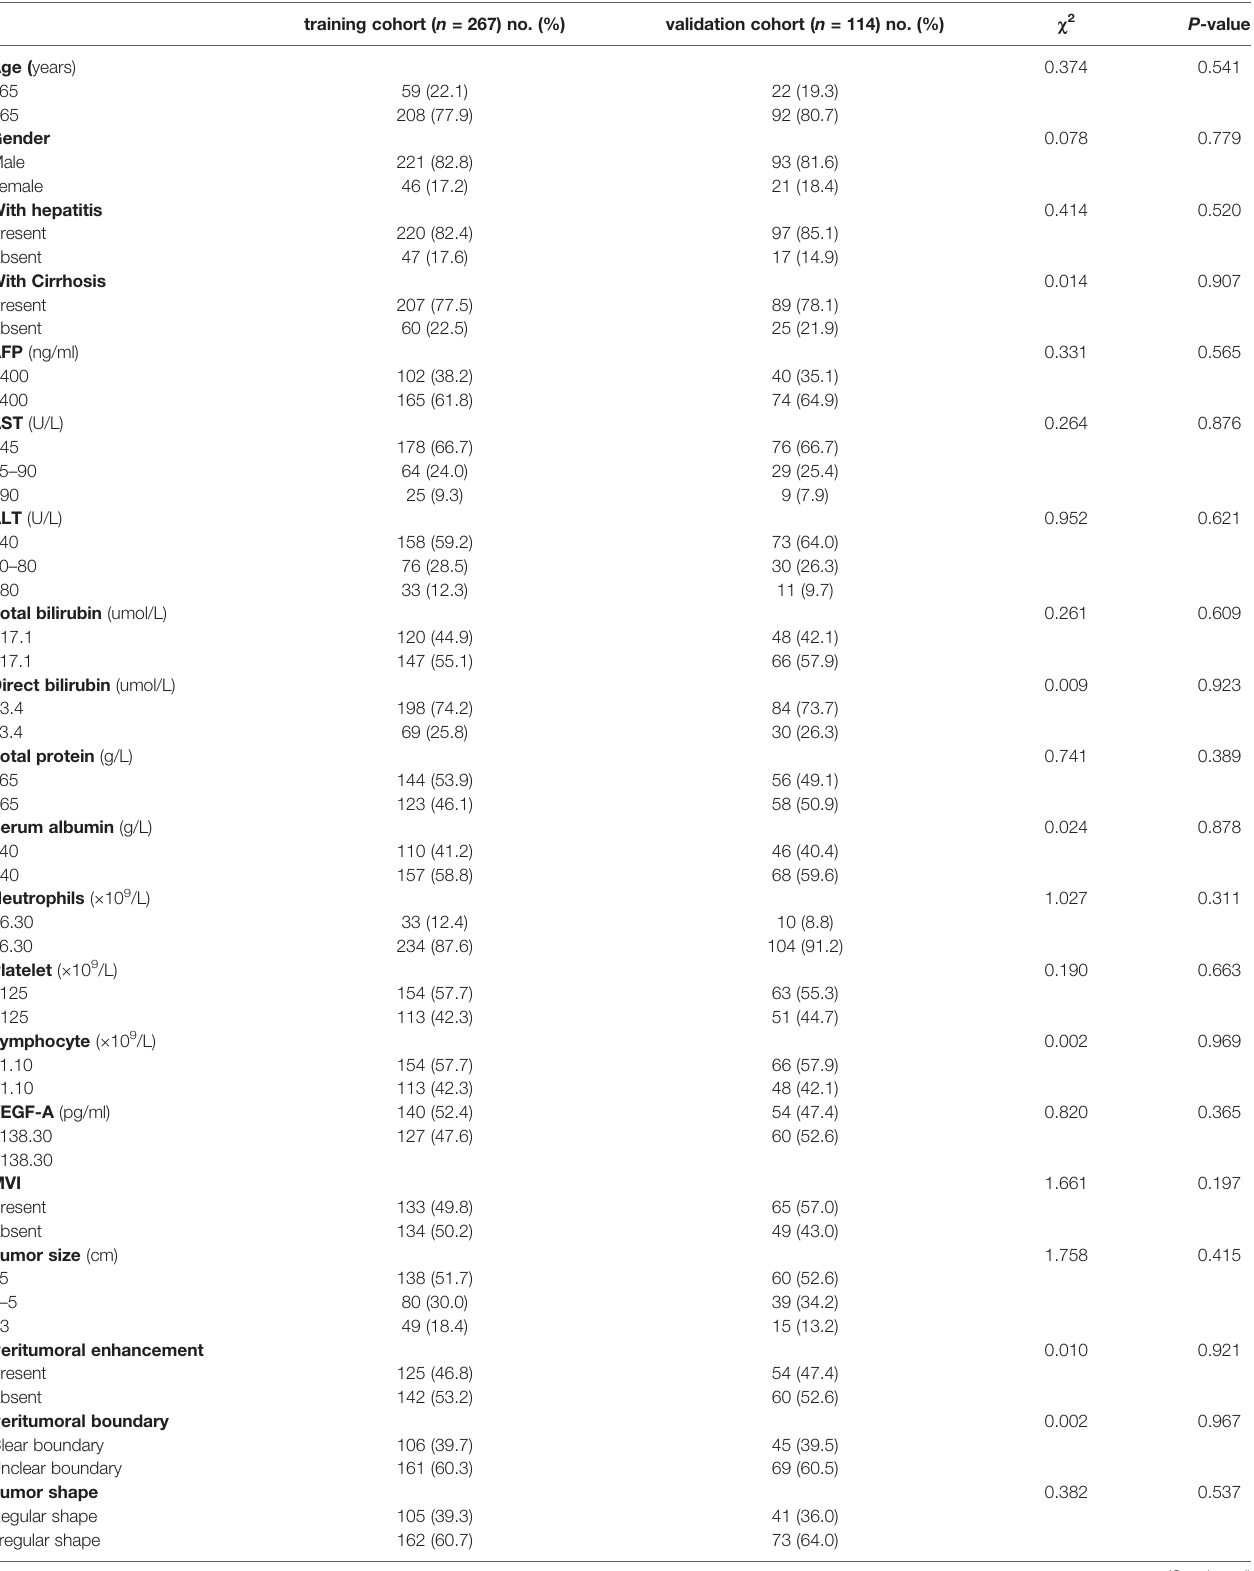
TABLE 1 | Clinical and imaging characteristics of HCC patients in the training and validation